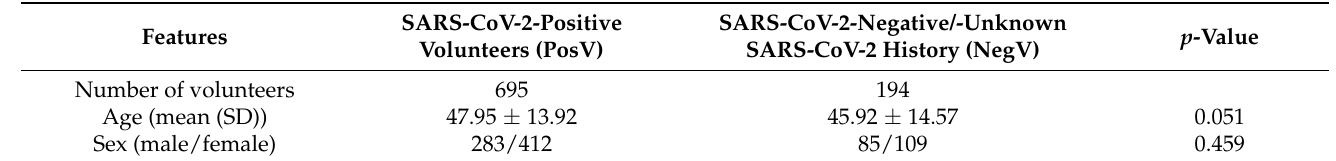
Table 1. Characteristics of study participants. The Mann–Whitney U test was used for age matching, and the Fisher’s exact test was used for gender